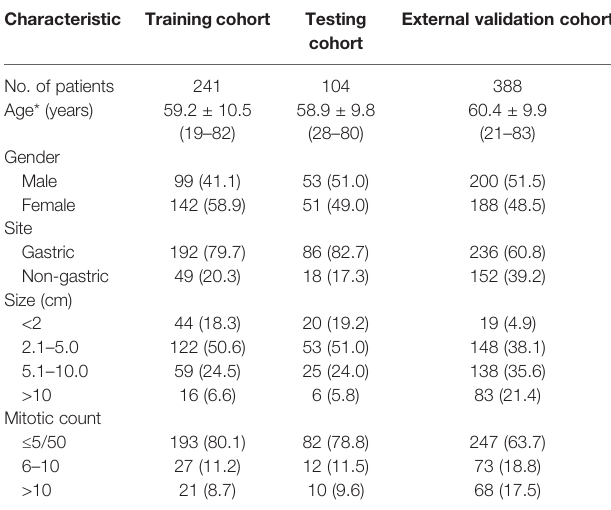
TABLE 1 | Characteristics of